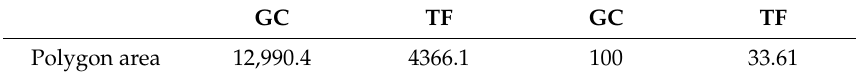
Table 6. Outcomes assessment in Gran Canaria and